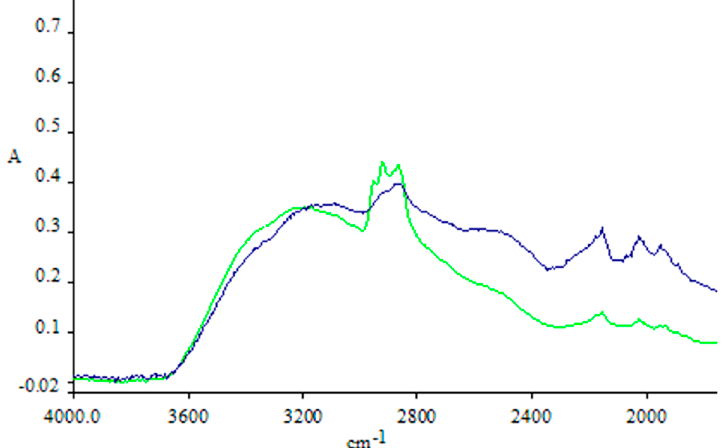
Figure 1. ATR-FTIR spectra of Cs-NPs Chitosan (blue line) and Cv–Cs-NPs (green line).